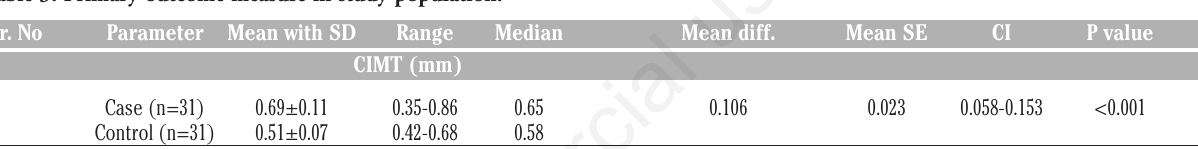
Table 3. Primary outcome measure in study